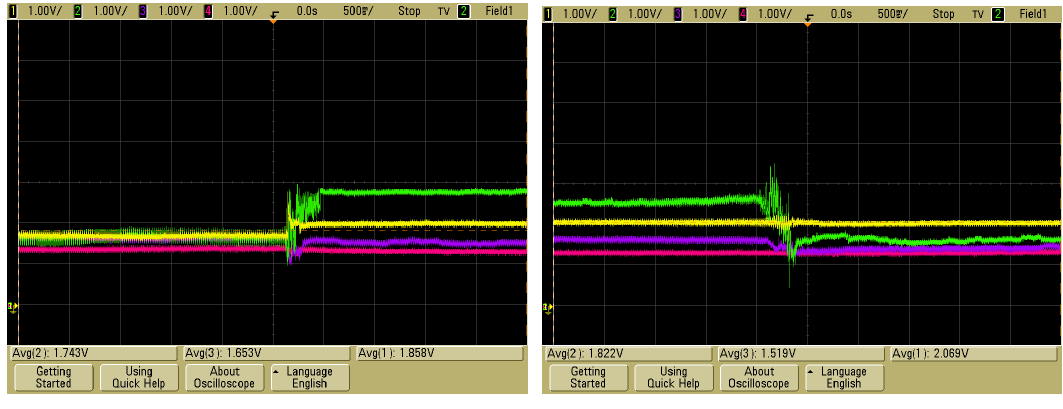
Figure 19. Application of the